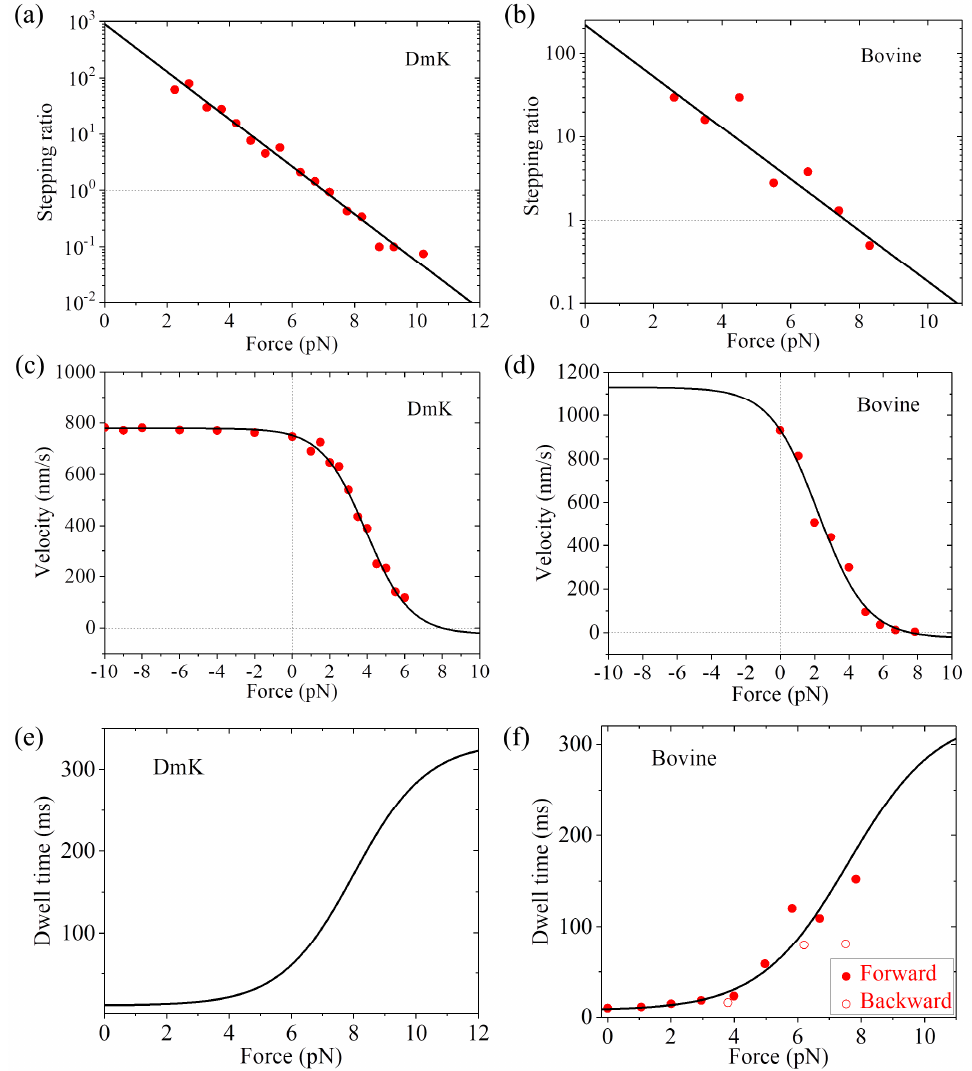
Figure 3. Dynamics of wild type (WT) kinesin-1 at saturating ATP. ( a ) Stepping ratio versus external force for DmK. Line represents analytical solution. Symbols are experimental data at 1 mM ATP taken from Carter and Cross [23]. Adapted by permission from Springer Nature: Carter, N.J.; Cross, R.A. Mechanics of the kinesin step. Nature 2005 , 435 , 308–312. Licence number: 4680770608424 ( b ) Stepping ratio versus external force for bovine brain kinesin (Bovine). Line represents analytical solution. Symbols are experimental data at 1 mM ATP taken from Nishiyama et al. [20]. Adapted by permission from Springer Nature: Nishiyama, M.; Higuchi, H.; Yanagida, T. Chemomechanical coupling of the forward and backward steps of single kinesin molecules. Nat. Cell Biol. 2002 , 4 , 790–797. Licence number: 4680771132891. ( c ) Velocity versus external force for DmK. Line represents analytical solution. Symbols are experimental data at 2 mM ATP taken from Andreasson et al. [24]. ( d ) Velocity versus external force for Bovine. Line represents analytical solution. Symbols are experimental data at 1 mM ATP taken from Nishiyama et al. [20] Adapted by permission from Springer Nature: Nishiyama, M.; Higuchi, H.; Yanagida, T. Chemomechanical coupling of the forward and backward steps of single kinesin molecules. Nat. Cell Biol. 2002 , 4 , 790–797. Licence number: 4680771132891. ( e ) Dwell time versus external force for DmK. Line represents analytical solution. ( f ) Dwell time versus external force for Bovine. Line represents analytical solution. Symbols are experimental data at 1 mM ATP taken from Nishiyama et al. [20]. Adapted by permission from Springer Nature: Nishiyama, M.; Higuchi, H.; Yanagida, T. Chemomechanical coupling of the forward and backward steps of single kinesin molecules. Nat. Cell Biol. 2002 , 4 , 790–797. Licence number: